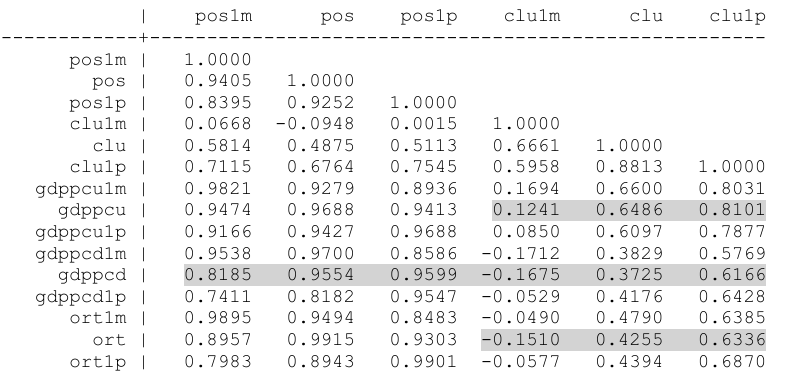
Figure 8. Cross-correlation matrix of parameters pos , clu , gdppcu , gdppcd , and ort with a 1-year shift for the period up to